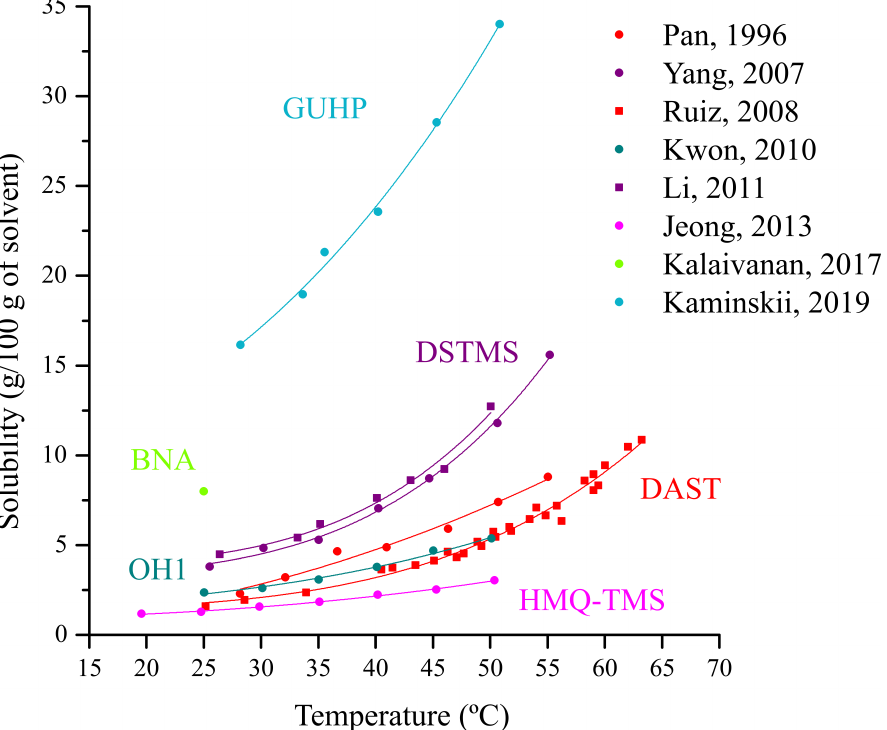
Figure 4. Comparison of solubility of some crystals in water (GUHP [169]), ethanol (BNA [153]), and methanol (DAST [93,150], DSTMS [151,160], OH1 [152], HMQ-TMS